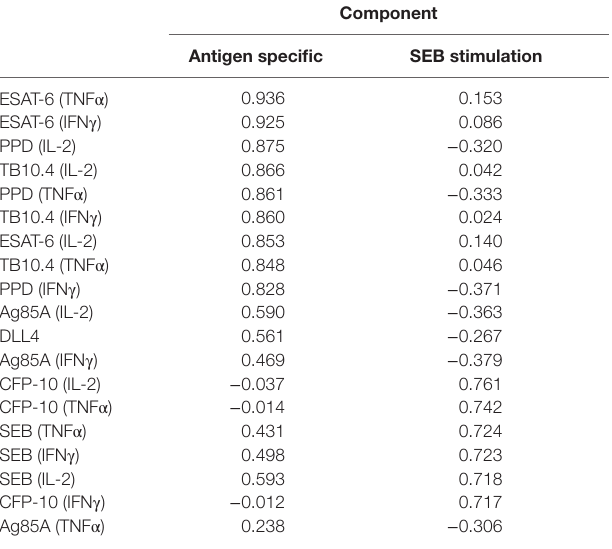
TaBle 1 | Principle component analysis of cytokine production in response to multiple antigens including PPD, esaT-6, TB4-10, cFP10, and ag85a, and Dll4 expression in patients with latent TB